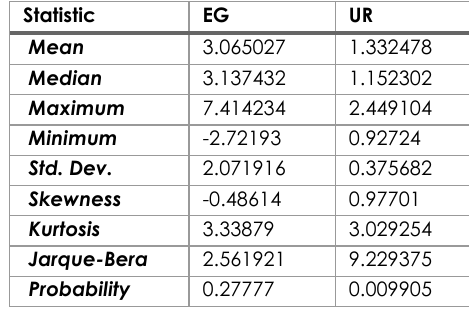
Table 1. Summary